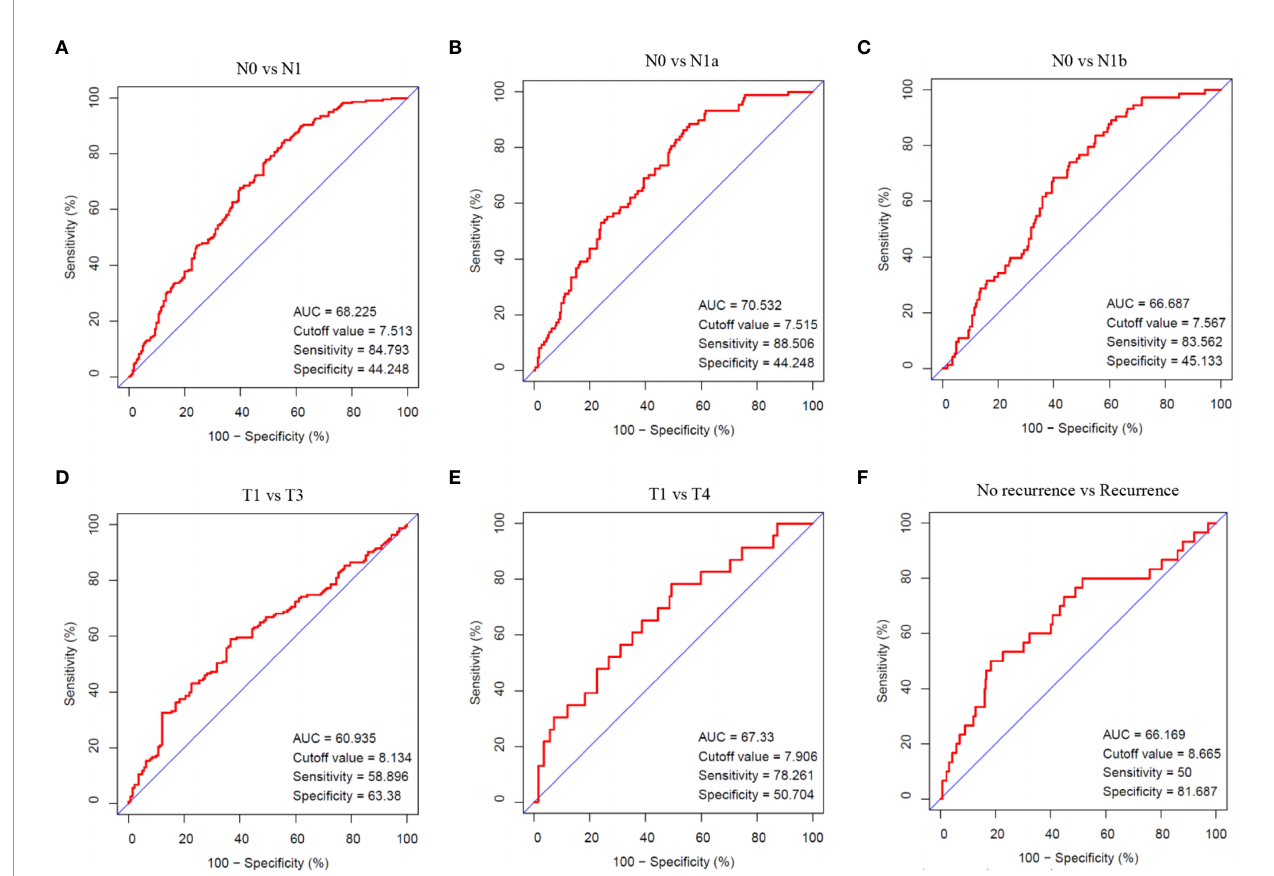
FIGURE 4 | The diagnostic value of ITGA3 in PTC progression using ROC analysis. (A) Comparison between N0 and N1 stages. (B) Comparison between N0 and N1a stages. (C) Comparison between N0 and N1b stages. (D) Comparison between T1 and T3 stages. (E) Comparison between T1 and T4 stages. (F) Comparison between no recurrence and recurrence groups. AUC, Area under